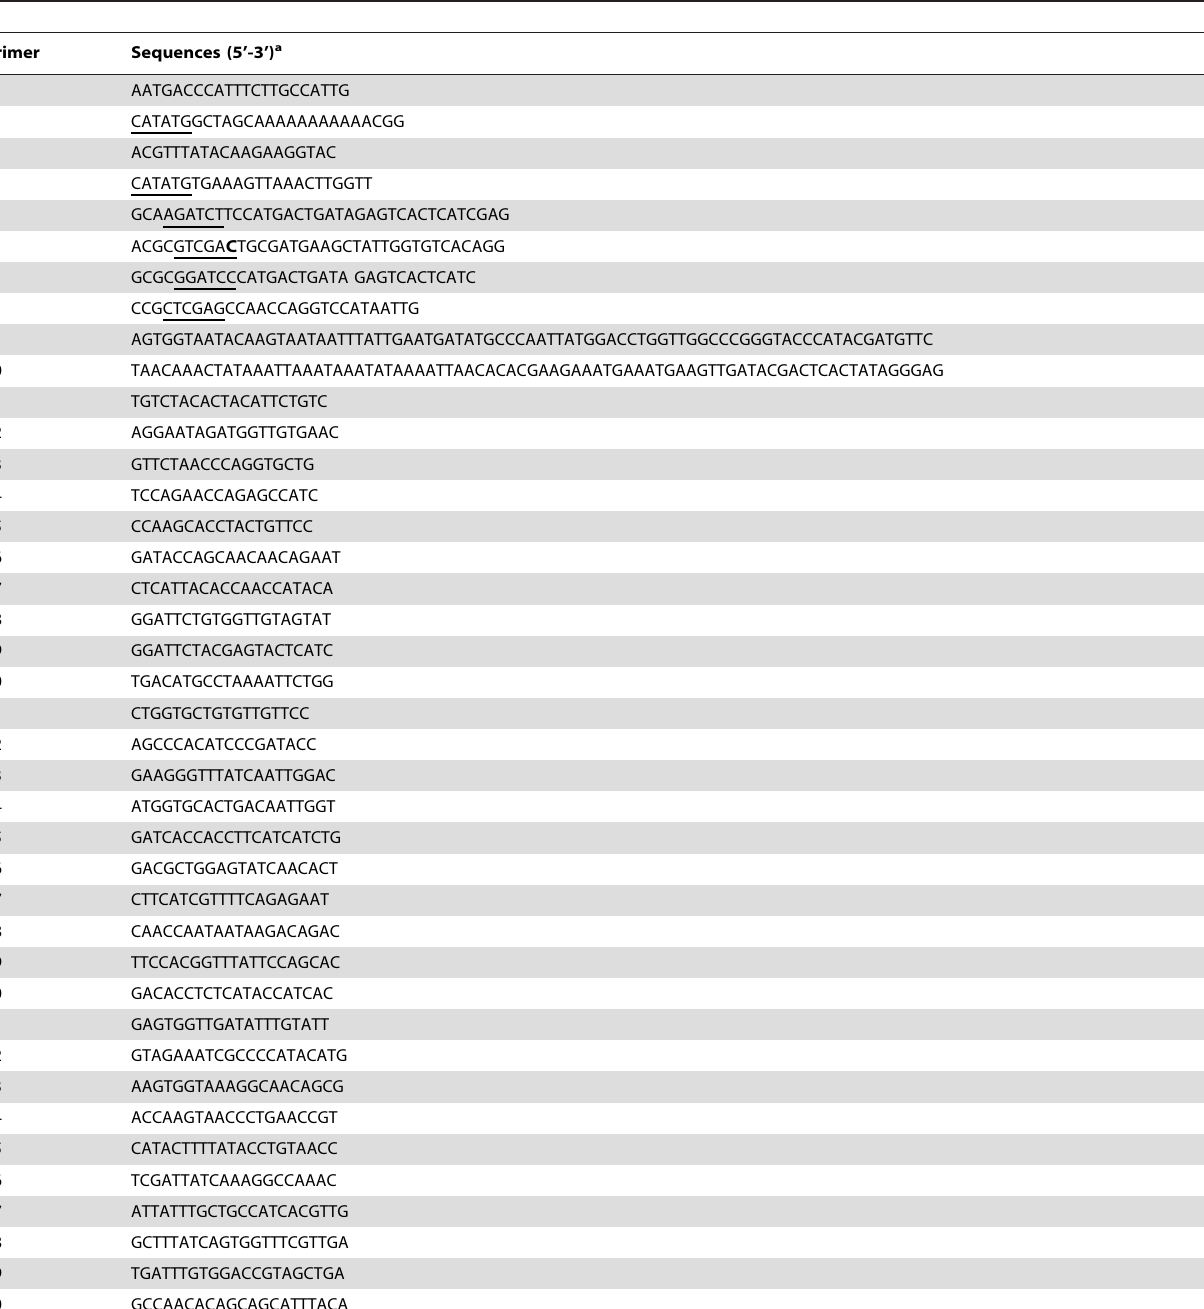
Table 2. Primers used in this